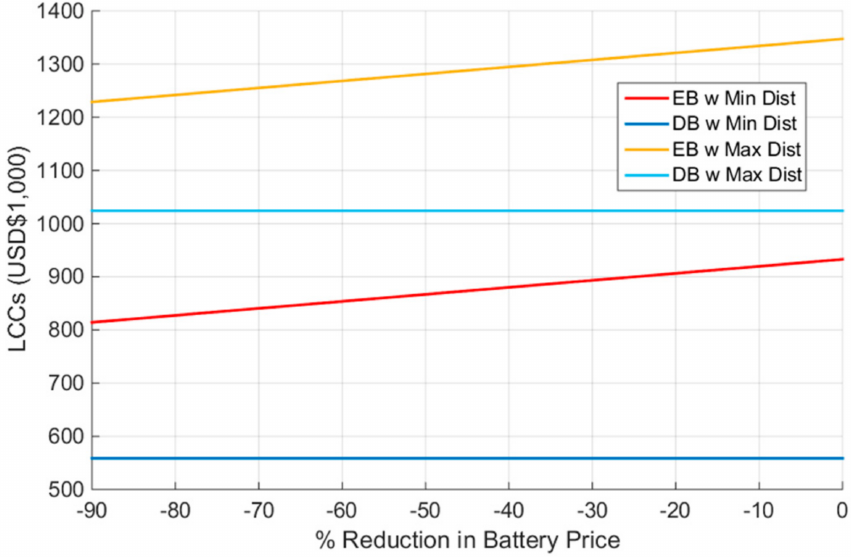
Figure 7. LCCs of the electric and diesel buses, against the percentage change of the scheduled and unscheduled maintenance rate of electric